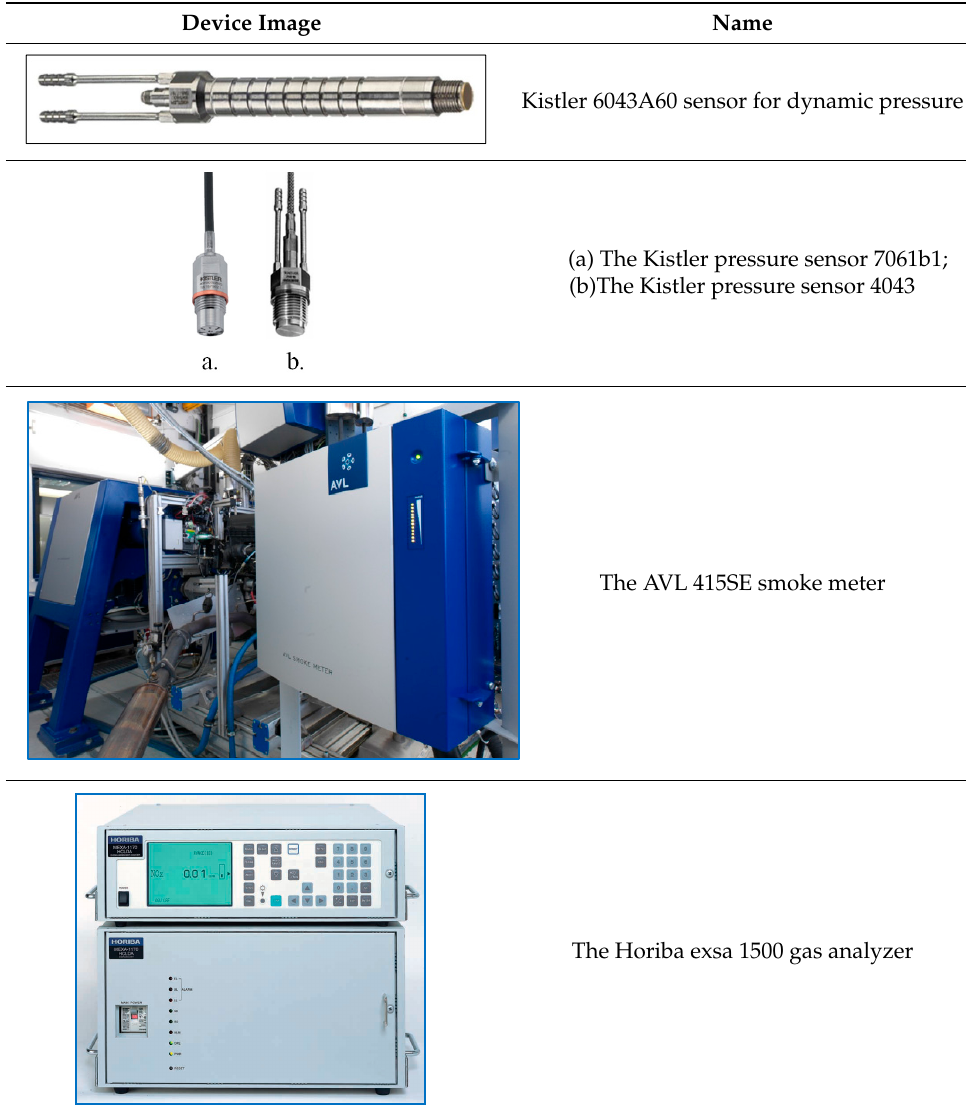
Table 1. Measurement devices used in the experimental research.